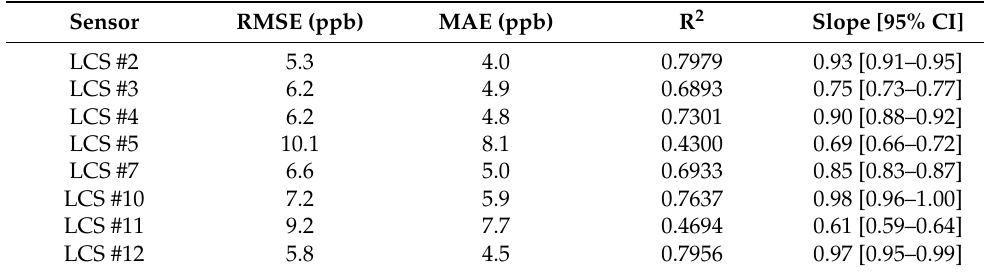
Figure 10. Average RMSE ( A ) and average R 2 ( B ) of the 8 LCSs for the Clarity 30-day and Clarity 15-day calibration from the test period (24 November 2020–12 February 2021). Table 4. Data summary for the Clarity 30-day calibration data from the 8 LCSs collocated at West Phoenix over the entire deployment period, calculated using West Phoenix FRM NO 2 data.